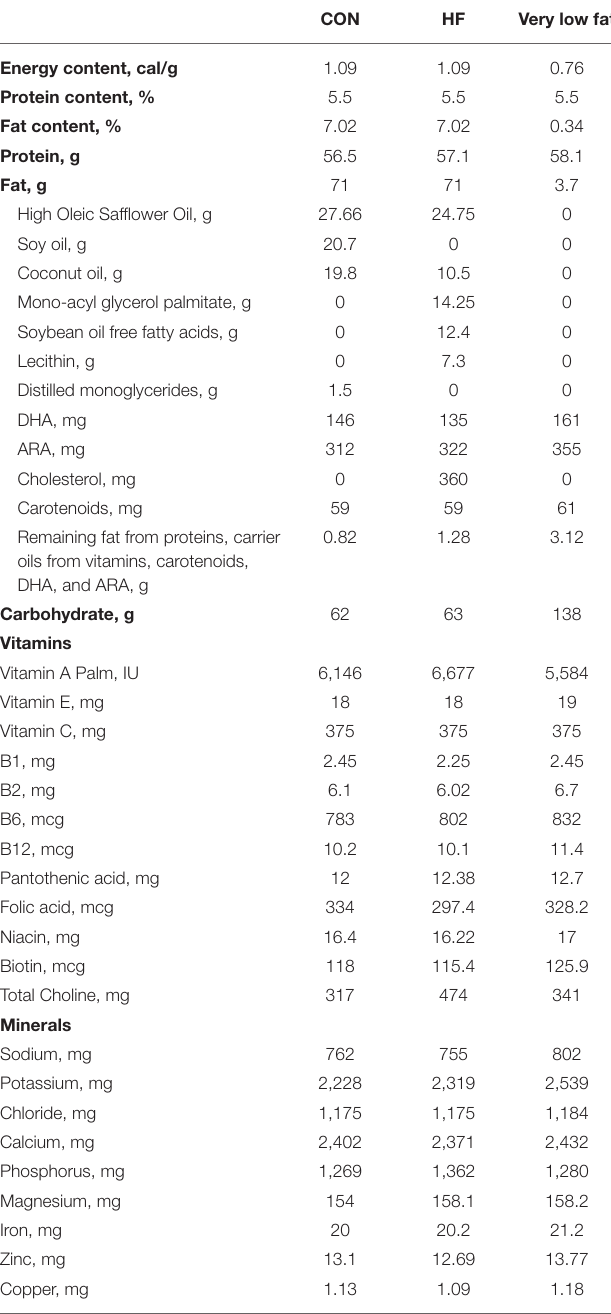
TABLE 1 | Nutrient composition of study formulas (Per L as